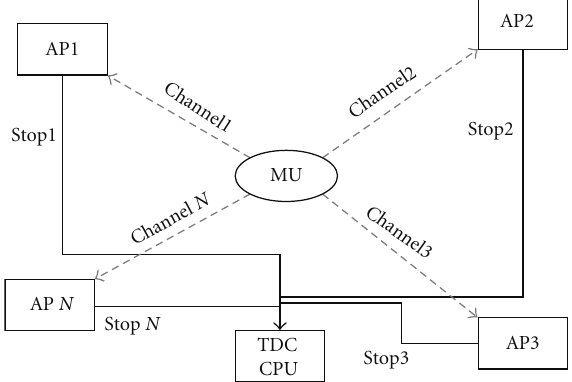
Figure 7: Typical TDoA localization system architecture. Synchro- nized APs receive UWB signals from an autonomous MU, which then are used to calculate its